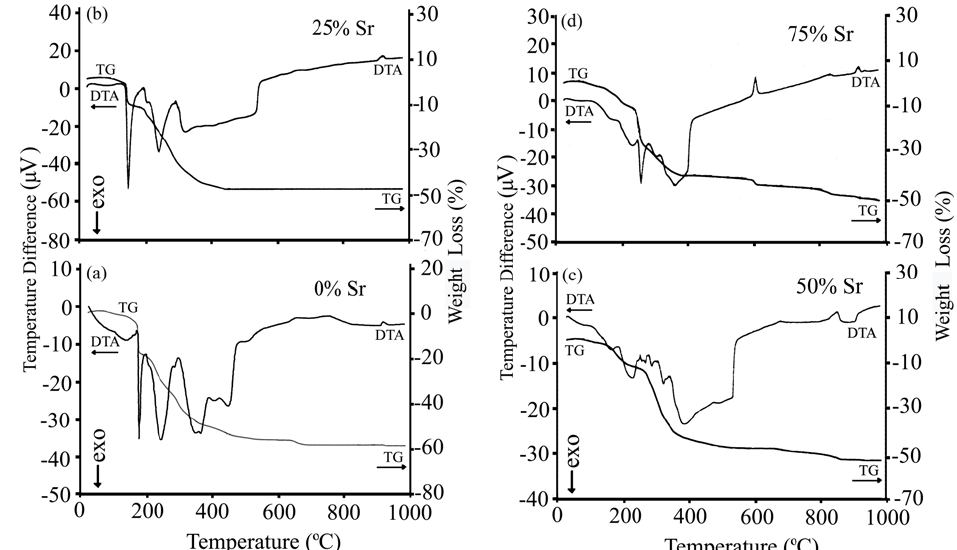
Figure 1. TG and DTA profiles of (a) La-Co-O, (b) La(0.75)-Sr(0.25)-Co-O, (c) La(0.5)-Sr(0.5)-Co-O, and (d) La(0.25)-Sr(0.75)-Co-O precursor gels. The heating rate was 10 o C min -1